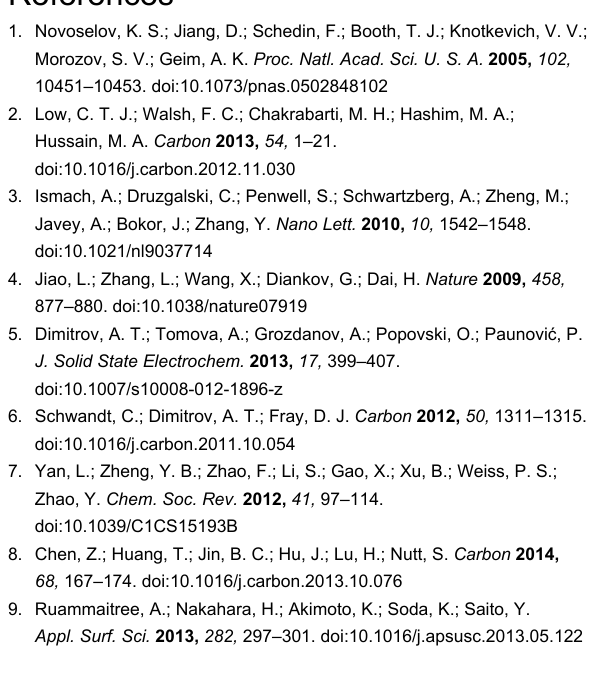
accuracy of the results. The results of the analyzed graphene samples, either obtained using the simple model or the enhanced model, show that these samples are